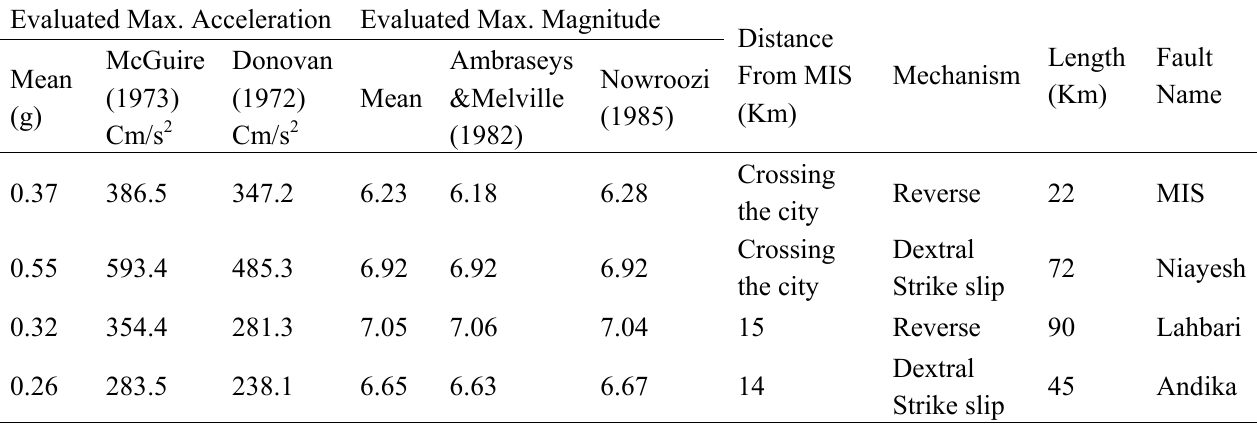
Table 2. Evaluation of seismic parameters of the main fault zones in Masjed-i-Soleiman area. Evaluated Max. Acceleration Evaluated Max. Magnitude